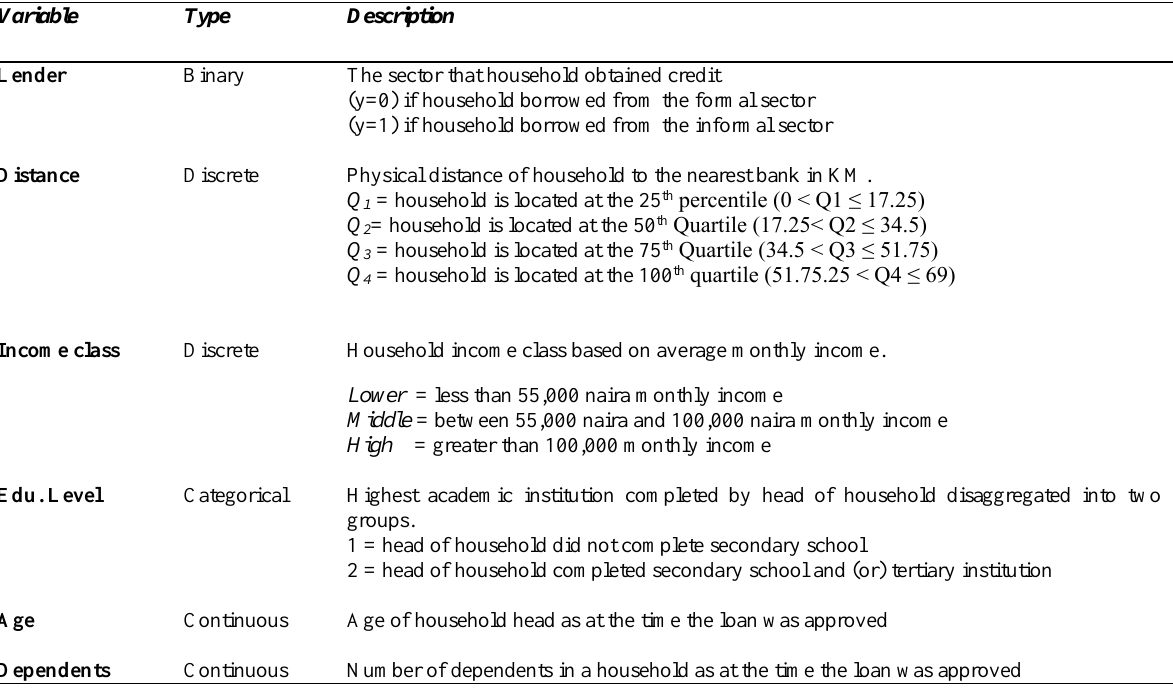
Table 1: Description of